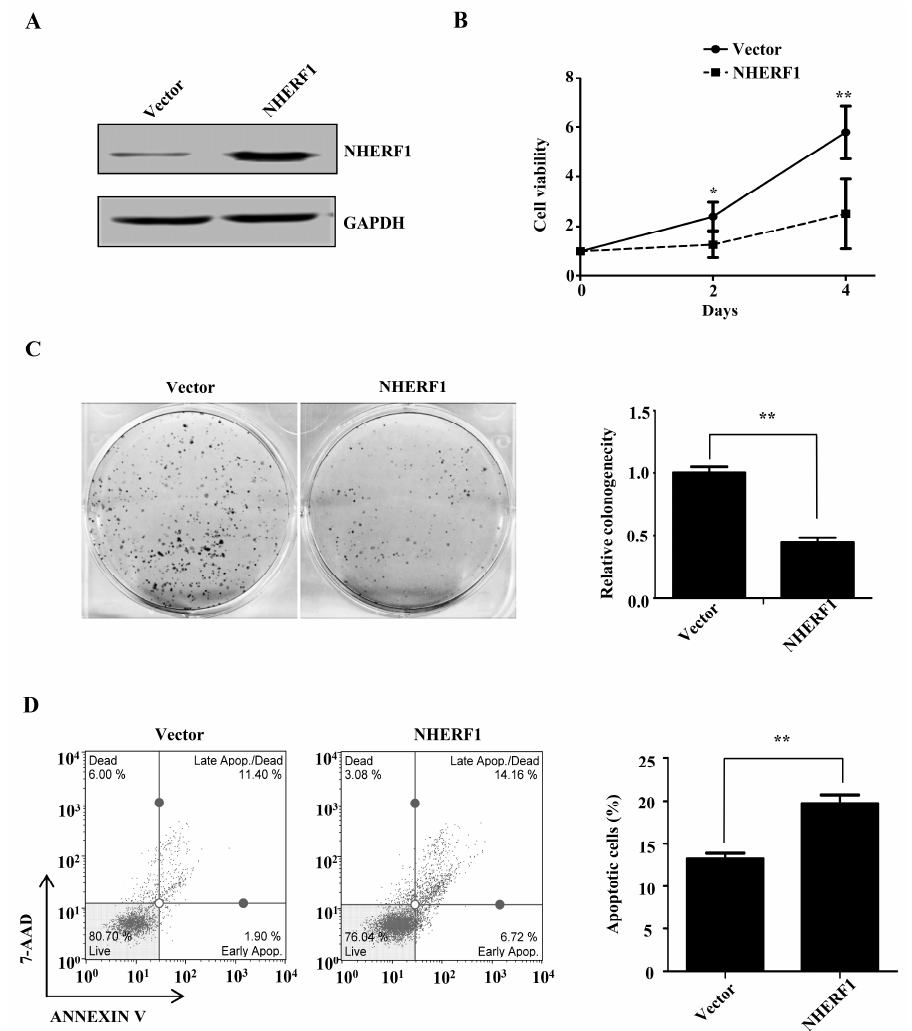
Figure 2. NHERF1 overexpression suppresses cell growth and promotes apoptosis in cisplatin-resistant HeLa cells. ( A ) Western blotting analysis of NHERF1 expression in cisplatin-resistant cells transfected with NHERF1; ( B – D ) Effect of NHERF1 overexpression on cell proliferation ( B ), colony formation ( C ), and cell apoptosis ( D ). ( B ) Control vector or NHERF1-transfected cisplatin-resistant HeLa cells were respectively cultured in 96-well plates and stained with CCK8 at 0, 2, 4 days. Growth of control and NHERF1-transfected cells was assessed by measuring absorbance at 450 nm. Values are presented relative to cell viability on day 0. Data represent the mean ± SD of three individual experiments; ( C ) Cells were plated at a concentration of 400 per well. Colonies were photographed ( left panel ) and counted ( right panel ) at 14 days. Values are expressed relative to the colony number formed by cells transfected with control vector. Data represent the mean ± SD of duplicate; ( D ) HeLa cells transfected with either control or NHERF1 were stained with 7-AAD and Annexin V. The percentage of cells in apoptotic phase was quantified with Muse™ Cell Analyser ( left panel ). Data represent the mean ± SD of three individual experiments ( right panel ). * p < 0.05, ** p < 0.01 compared with vector-transfected